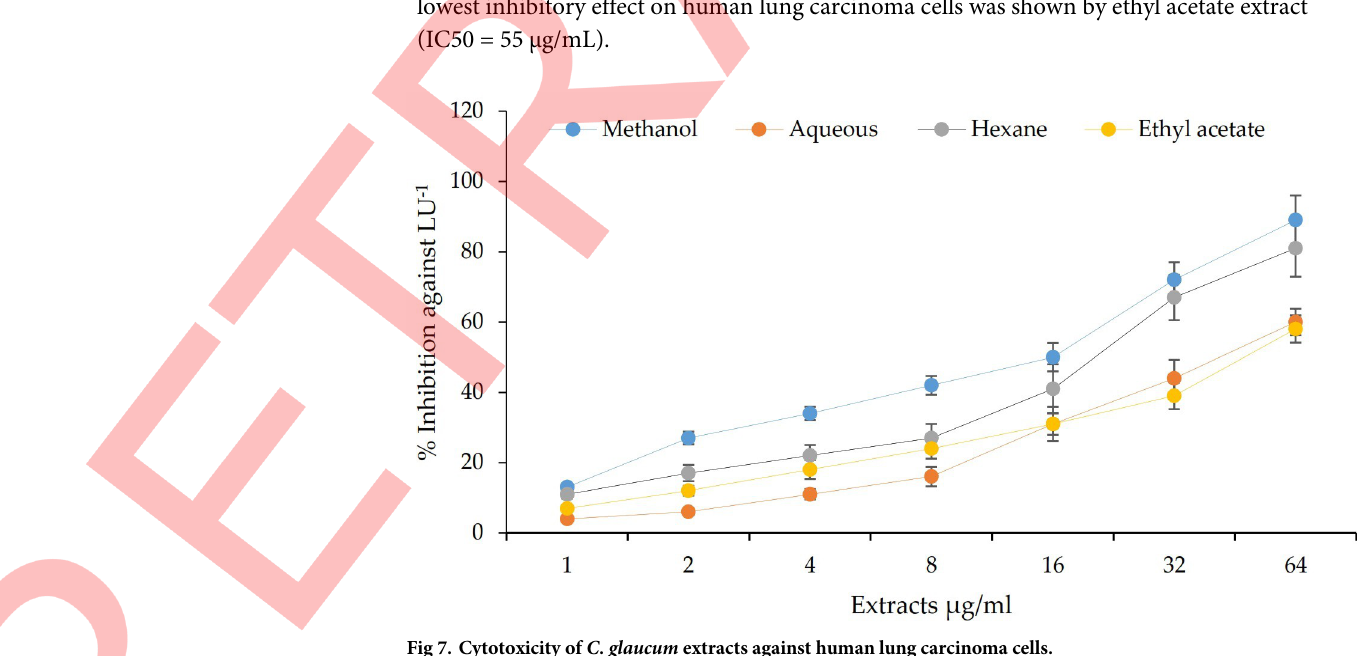
PLOS ONE | https://doi.org/10.1371/journal.pone.0255502 October 29,